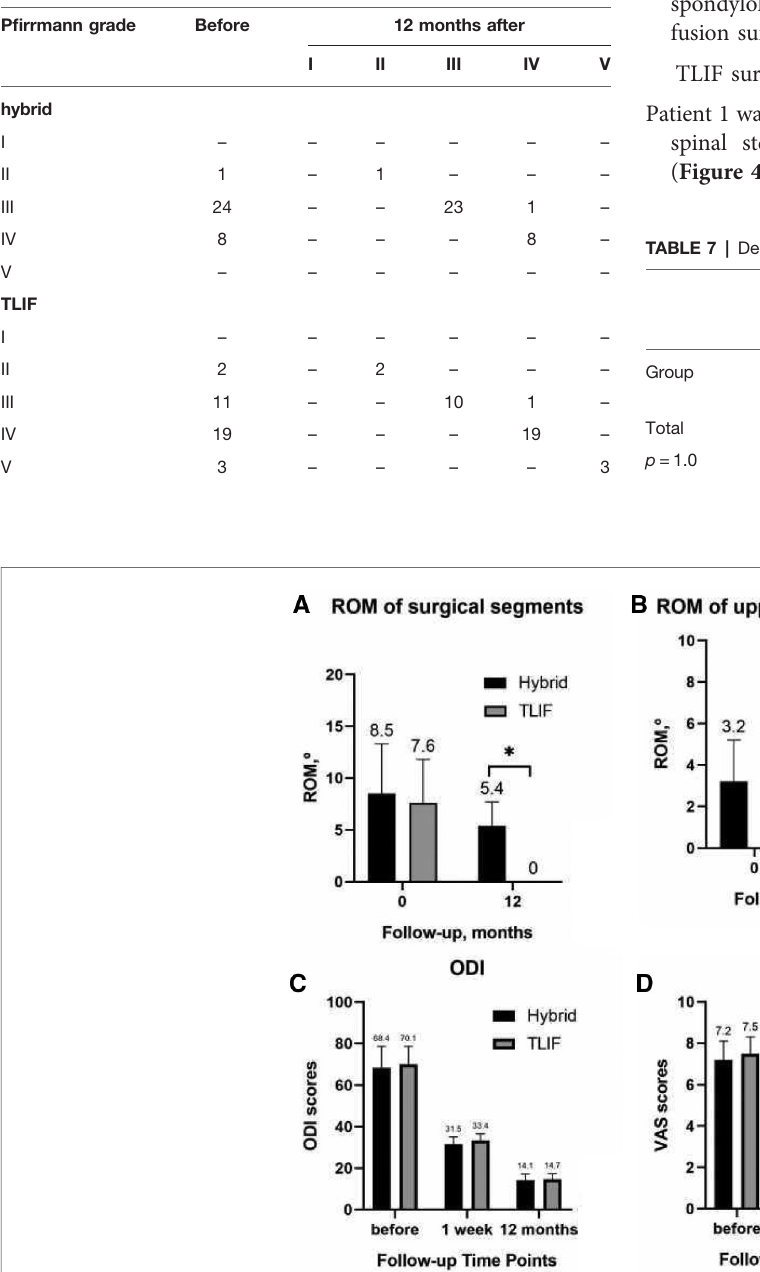
TABLE 6 | P fi rrmann grade of the hybrid